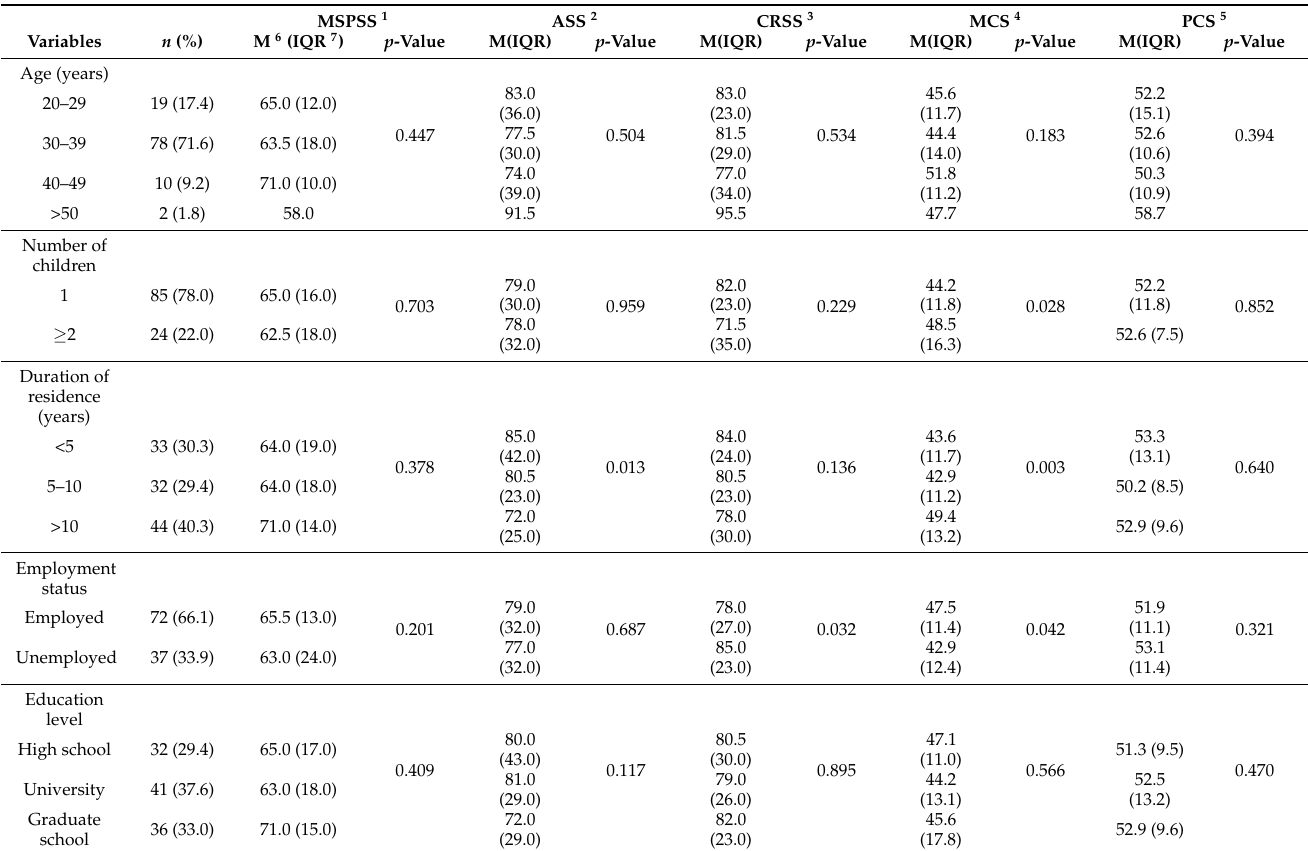
Table 1. The relationships between the demographic factors and the main variables ( n =